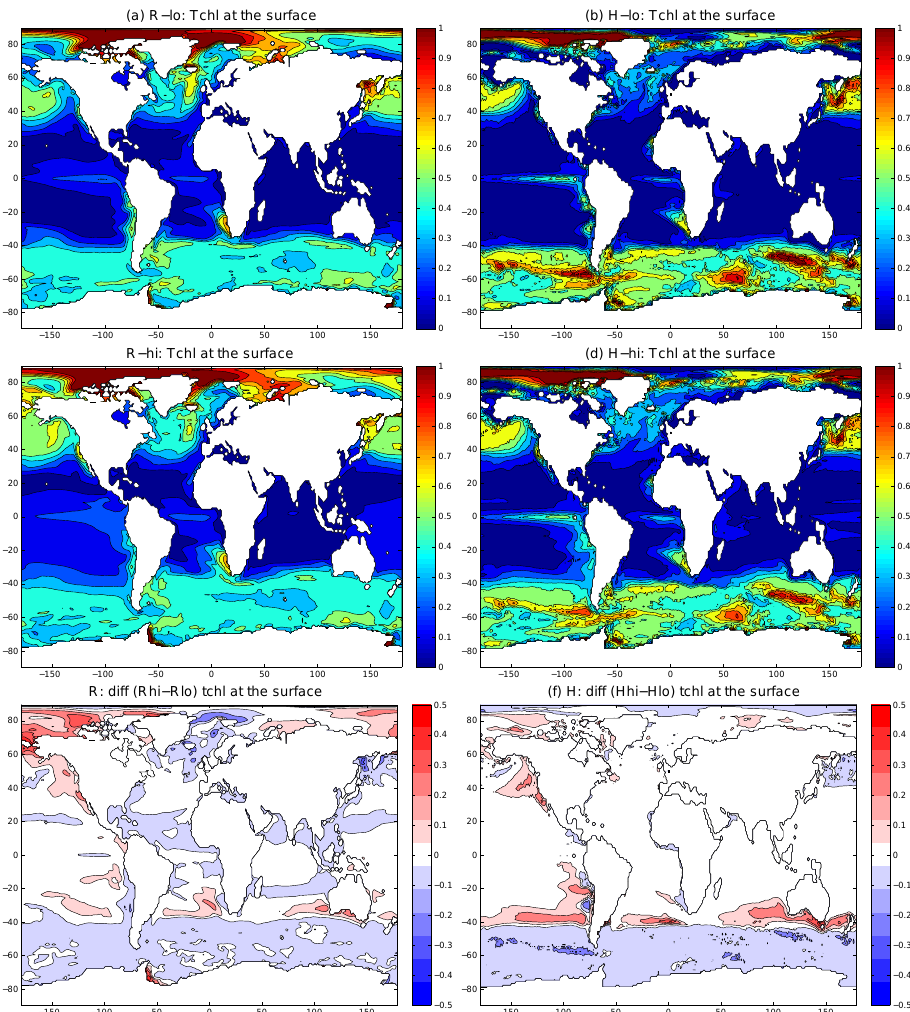
Fig. 7. Surface distributions of chlorophyll in (a) GISSER and (b) GISSEH with low remineralization rate, (c) GISSER and (d) GISSEH with high remineralization rate. Units are in mgCm − 3 . (e), (f) Differences in surface chlorophyll between same model runs but with varying remineralization rate. Units are in mgCm − 3 . Chlorophyll distributions are determined by light and nutrient availability and the temperature of seawater. GISSEH predicts higher chlorophyll concentrations than GISSER (Fig. 7) in two main regions: 1) the tropical upwelling regions, where water originates from deeper, generally richer in nitrates, layers and 2) the Southern Ocean (south of 50 ◦ S) where iron concentrations are higher.